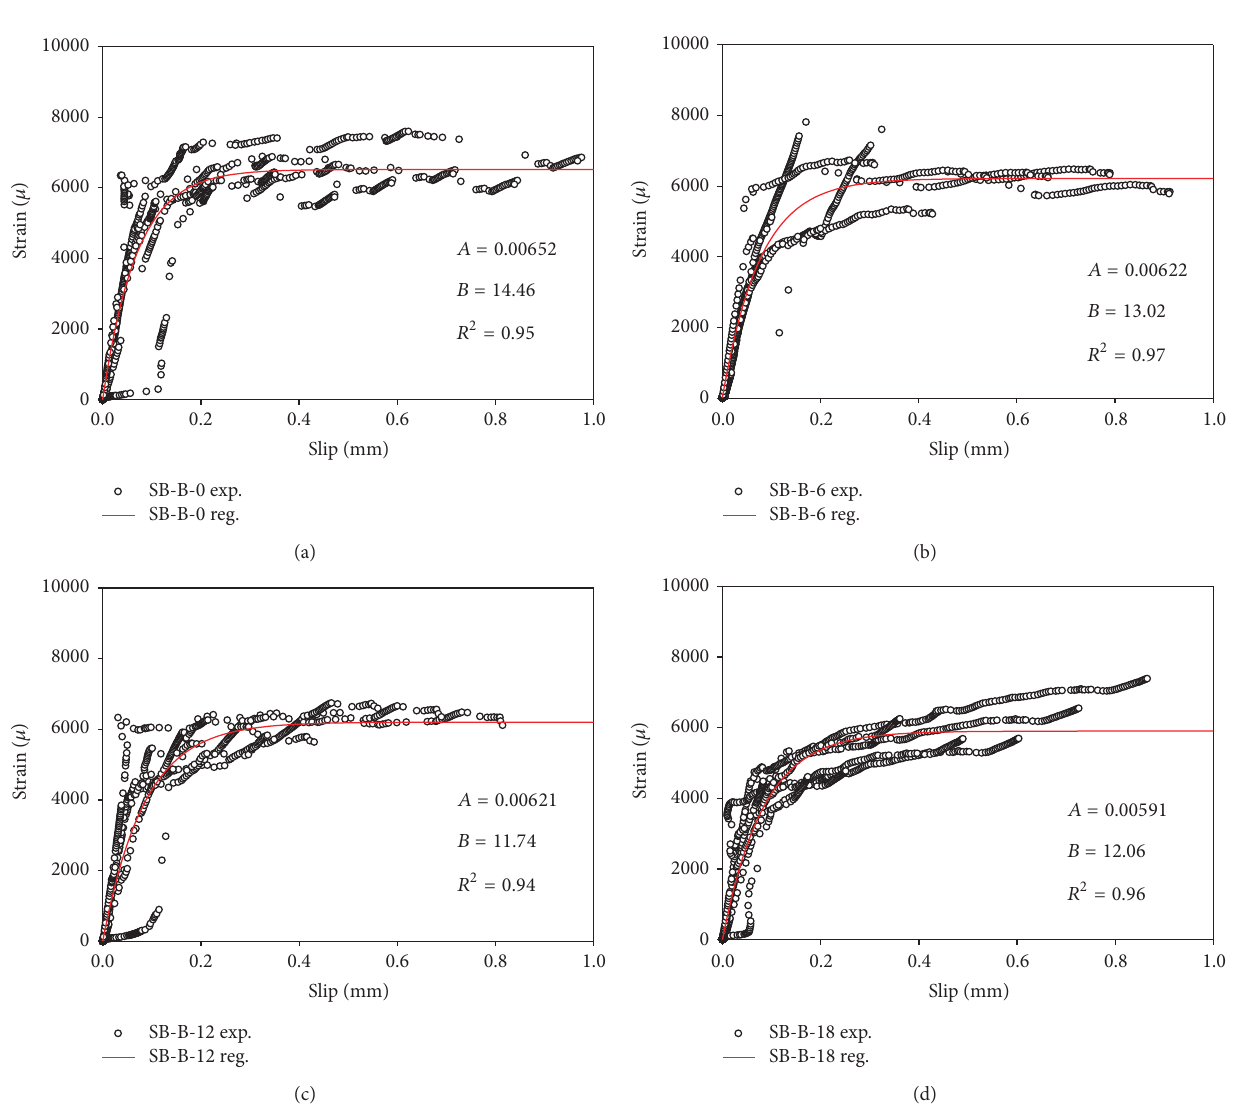
Figure 6: Regressed 𝜀 - 𝑠 curve from the experimental results for specimen